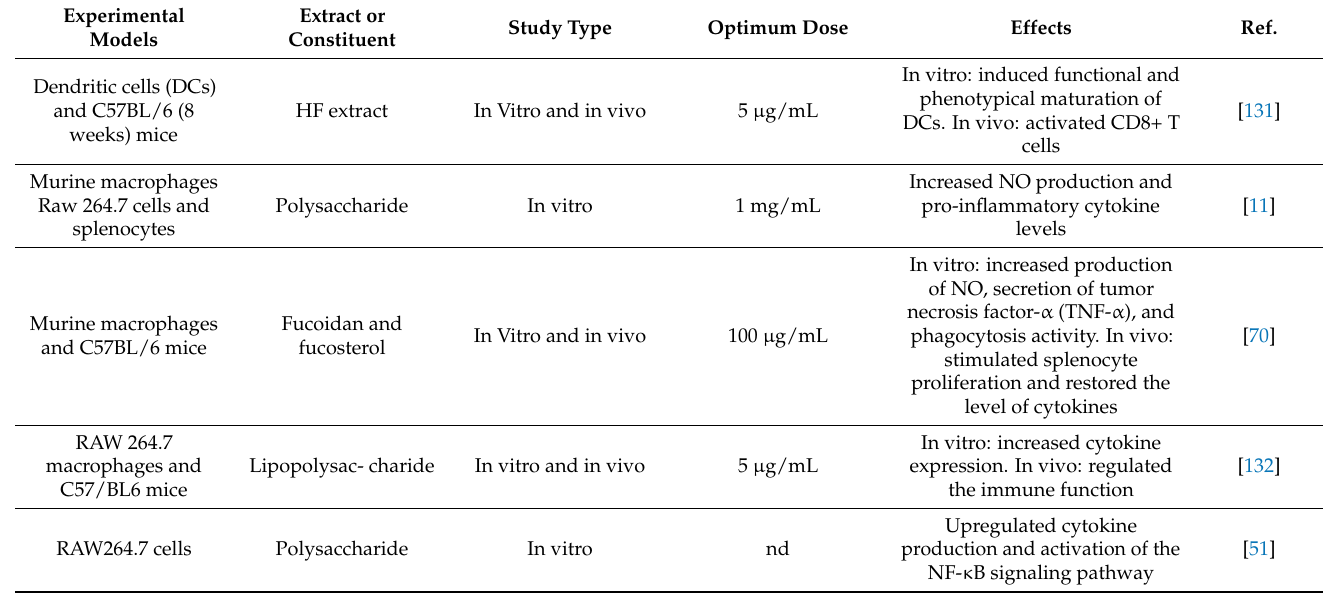
Table 12. Summary of the immunomodulatory effects of H. fusiformis